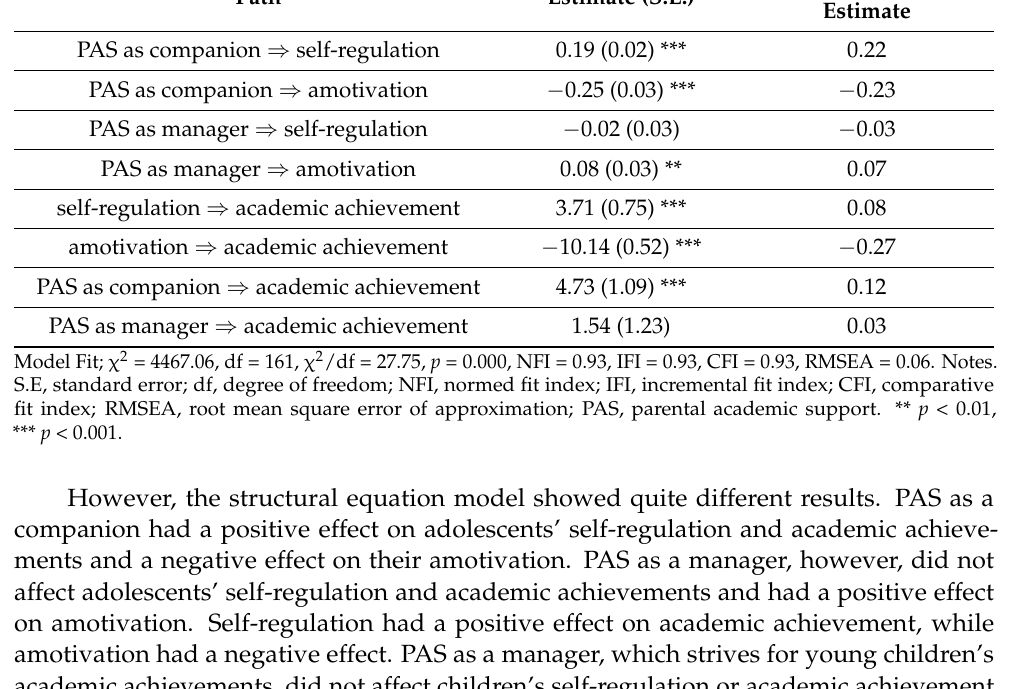
amotivation. ** p < 0.01, *** p < 0.001.